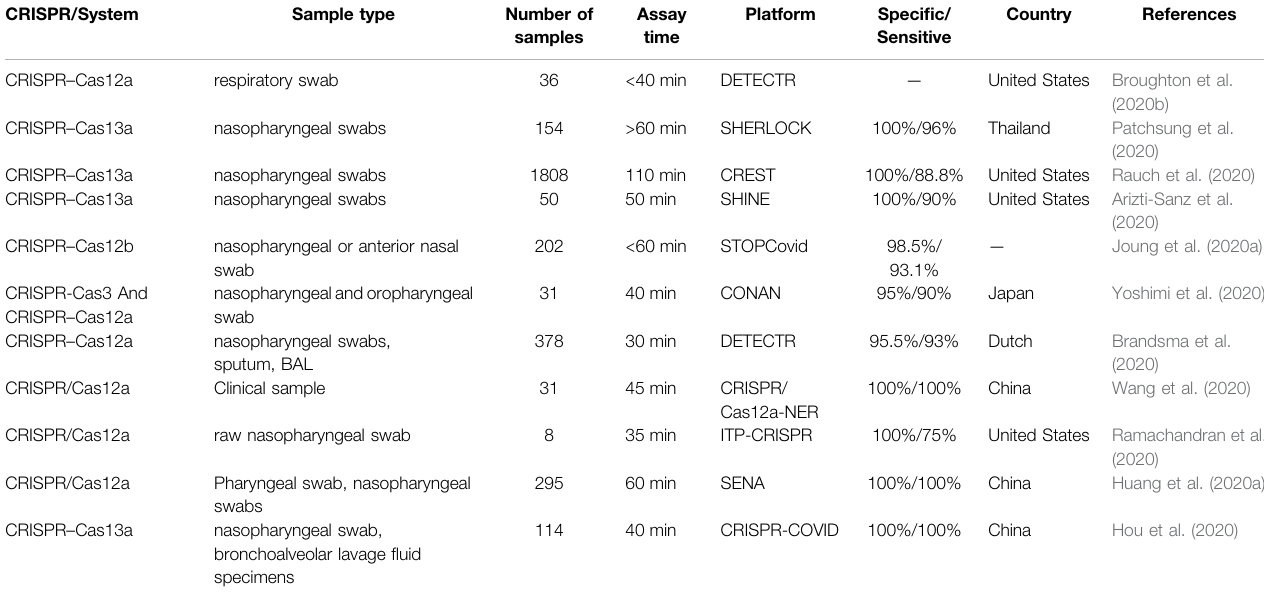
TABLE 1 | Some CRISPR-based SARS-CoV-2 diagnostic